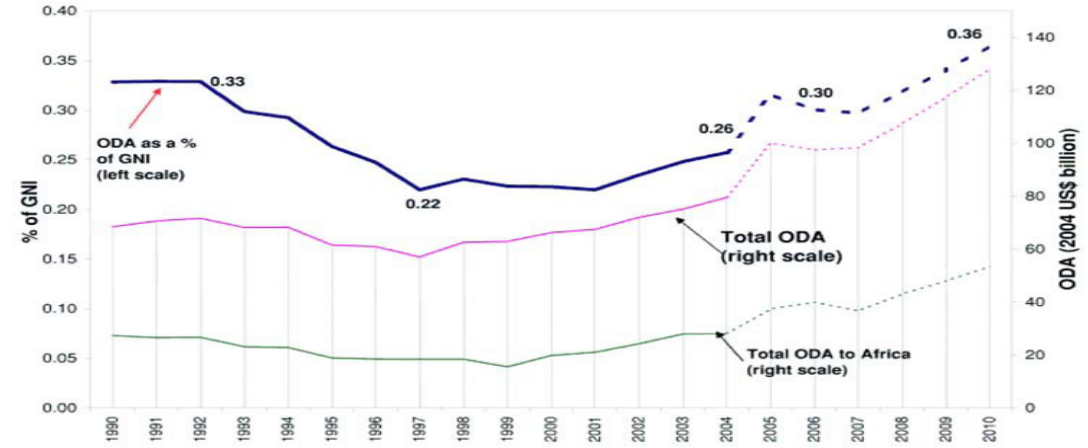
Figure 1: Scale of ODA and donor